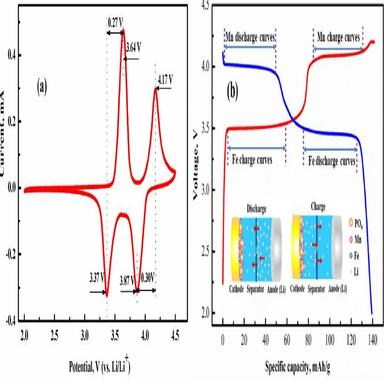
(a) Cyclic voltammetry profiles of LiMn0.5Fe0.5PO4/C and (b) the 1st charge-discharge curves.